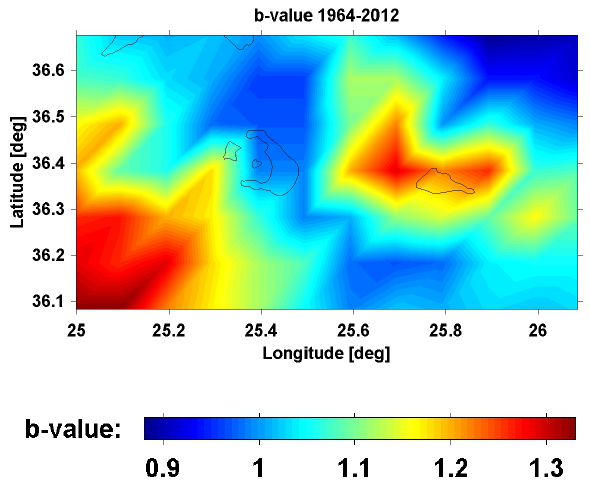
Fig. 8. b-value map showing the spatial variation in the Santorini island volcanic complex from 1966 till 2012, calculated from the declustered seismicity catalogue of